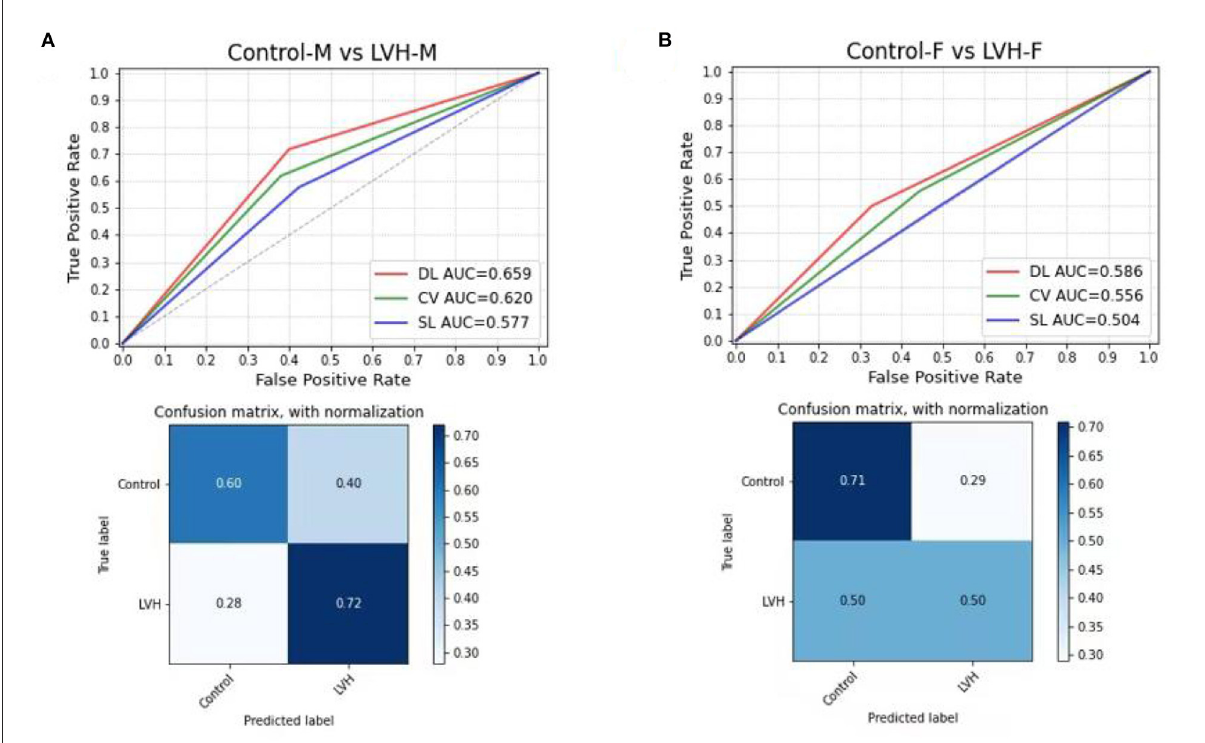
FIGURE3 Comparing the DL model with Cornell voltage and Sokolow-Lyon voltage to predict LVH, the confusion matrix for predicting control and LVH using the DL model in the test set; (A) for male patients; (B) for female patients. DL, deep learning model; CV, Cornell voltage; SL, Sokolow-Lyon